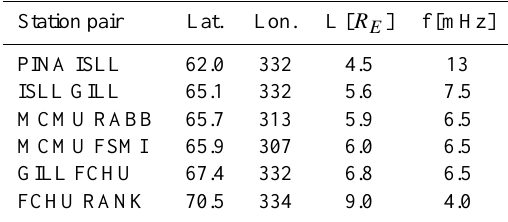
Table 1. Locations in magnetic coordinates and L-value of sta- tions belonging to the CARISMA chain. The fundamental eigen- frequency f was determined by the cross-phase technique. Station pair Lat.